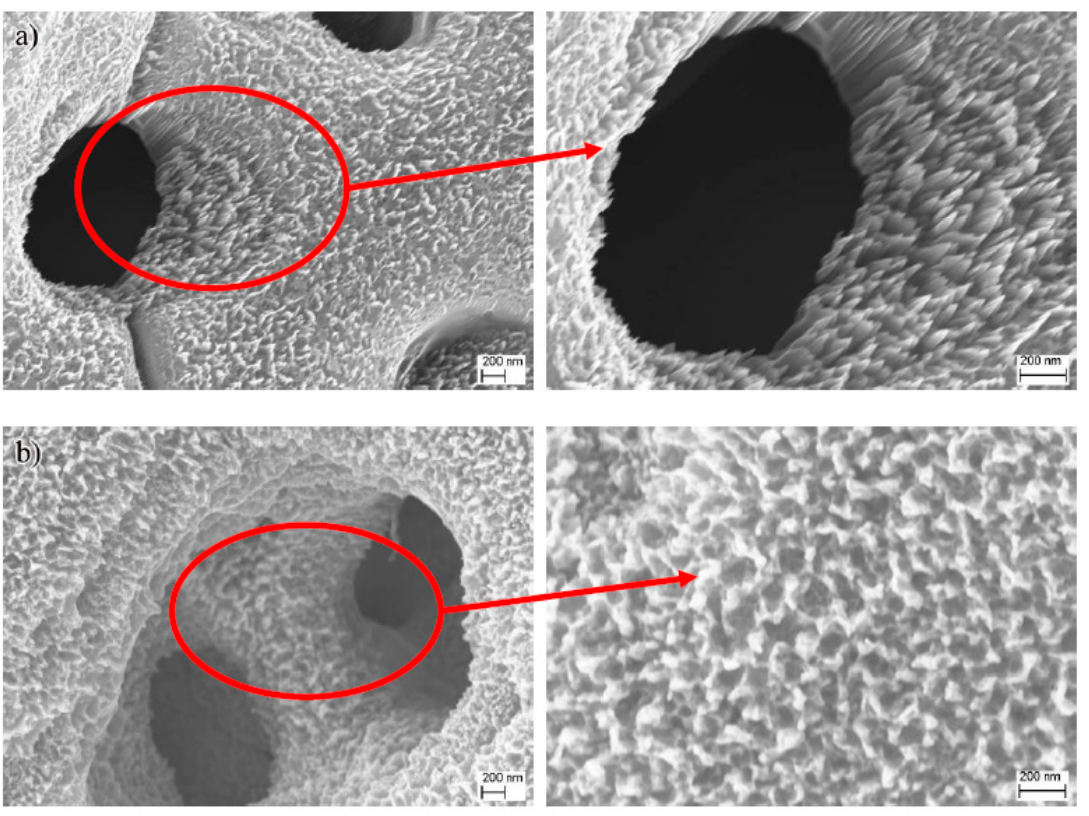
Figure 3. Surface images of nitrogen ion implantation MAO specimen under high magnification morphology: ( a ) Ti-MAO-N10 and ( b ) Ti-MAO-N20.